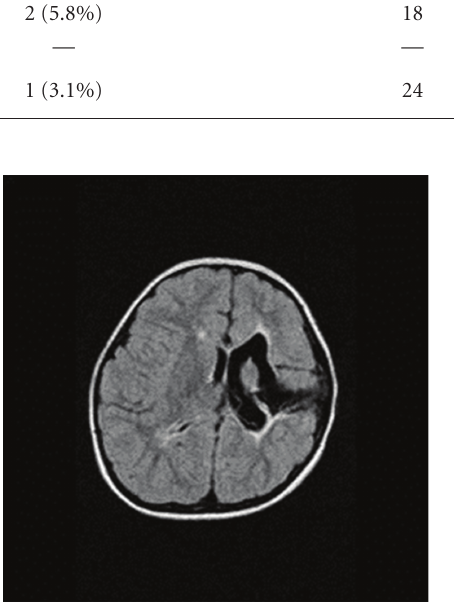
Figure 4: T2W Axial flair MRI image of a 3-year-old boy with infantile hemiplegia seizure syndrome